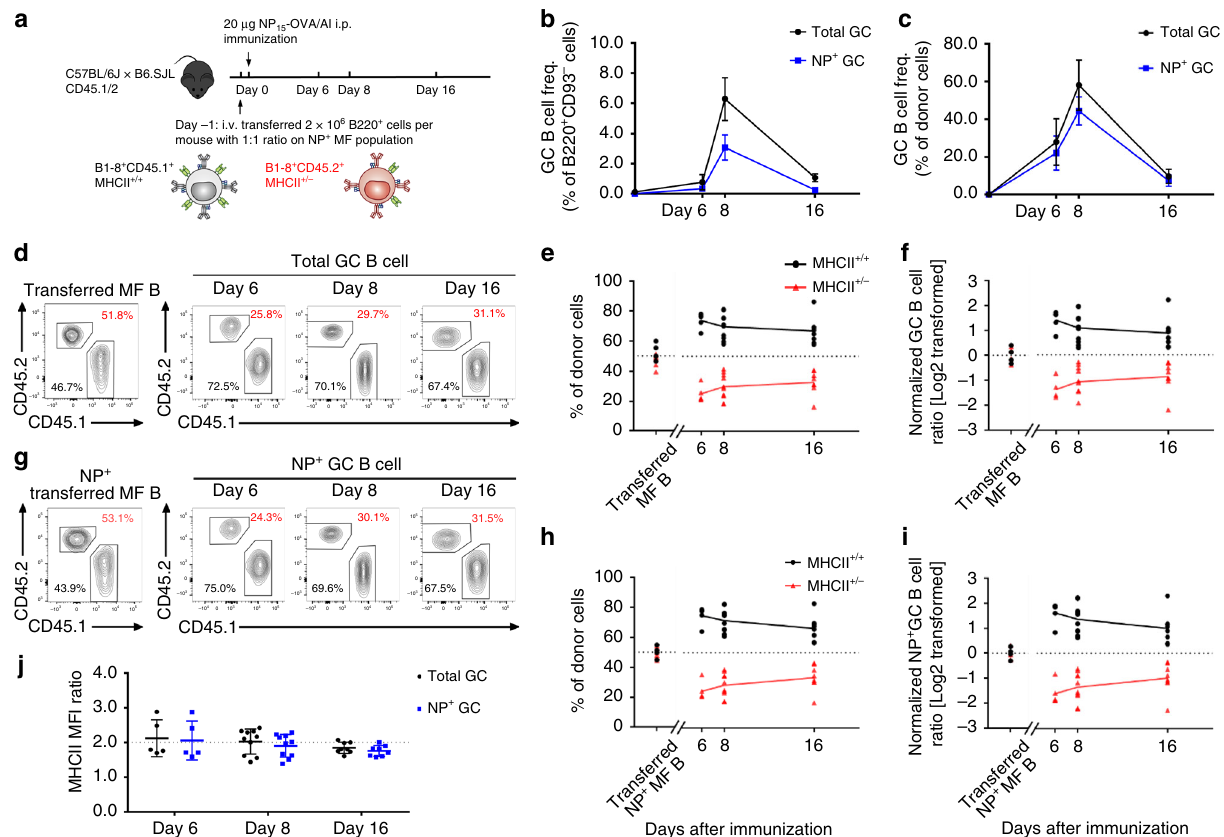
Fig. 2 MHCII + / + B cells are advantaged in populating early GCs. a Diagrammatic representation of the experimental design. Recipient mice (CD45.1 + CD45.2 + ) received i.v. transfers of 1:1 mixtures of NP-reactive, congenically marked B1-8.MHCII + / + (CD45.1 + ) and B1-8.MHCII + / − (CD45.2 + ) B cells on day − 1. These mice were subsequently immunized i.p. with NP-OVA in alum (day 0). Splenocytes were harvested, labeled and examined by fl ow cytometry on days 0 (naïve), 6, 8, and 16 post immunization. b , c Kinetics of b total and c donor only GC and NP + GC responses. d – f Proportions of B1-8. MHCII + / + and B1-8.MHCII + / − cells within donor-derived total GC B-cell compartments. d Representative fl ow diagrams, e combined results and f normalized kinetics from three independent experiments are shown. g – i Proportions of B1-8.MHCII + / + and B1-8.MHCII + / − cells within donor-derived NP- binding GC B-cell compartments. g Representative fl ow diagrams, h combined results, and i normalized kinetics from three independent experiments are shown. Numbers indicate the frequencies of cells from B1-8.MHCII + / + (CD45.1 + , black) and B1-8.MHCII + / − (CD45.2 + , red) donors ( d , g ). Symbols represent the frequencies of CD45.1 + B1-8.MHCII + / + (black circles) or CD45.2 + B1-8.MHCII + / − (red triangles) cells among each B-cell compartment of donor cells ( e , h ). To normalize against B-cell chimerism variations in individual recipient animals, donor ratios of MHCII + / + :MHCII + / − in GC B cells were normalized to the donor ratios of MHCII + / + :MHCII + / − in MF B cells (homo/hemi; black). Similarly, donor ratios of MHCII + / − :MHCII + / + in GC B cells were normalized to the donor ratios of MHCII + / − :MHCII + / + in MF B cells (hemi/homo; red) ( f , i ). j The ratio of MHCII MFI values on MHCII + / + donors over MHCII + / − donors (total GC B cells, black circles; NP + GC B cells, blue squares). Each symbol represents an individual mouse from at least three independent experiments ( n = 5 – 10 at each time point) and the bars indicate the mean values (±S.D.) of each group. The cell populations and gatings were de fi ned as Supplementary Fig.